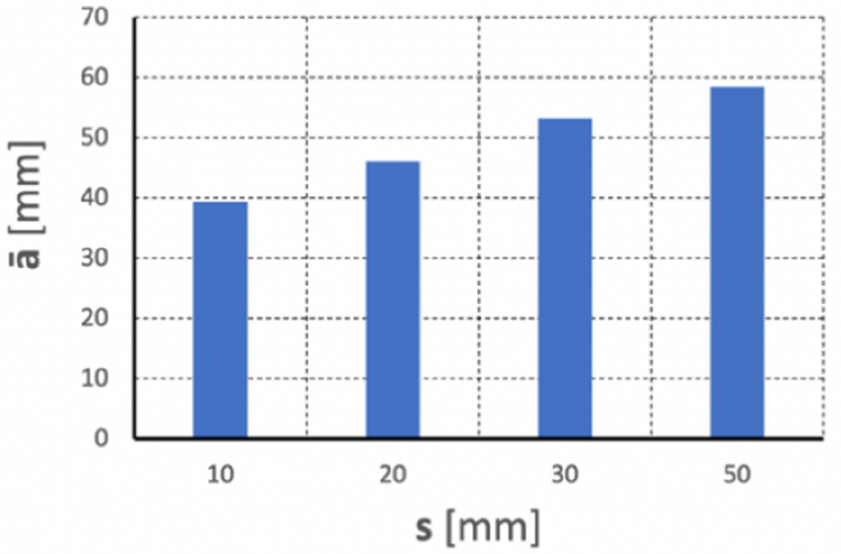
Figure 7. Influence of distance, s, from the homogenizing nozzle outlet to the comminuting disk on coal comminution efficiency. Test conditions: p = 200 MPa, d w = 0.7 mm, d c 1 = 2.4 mm, d h = 4.5 mm,